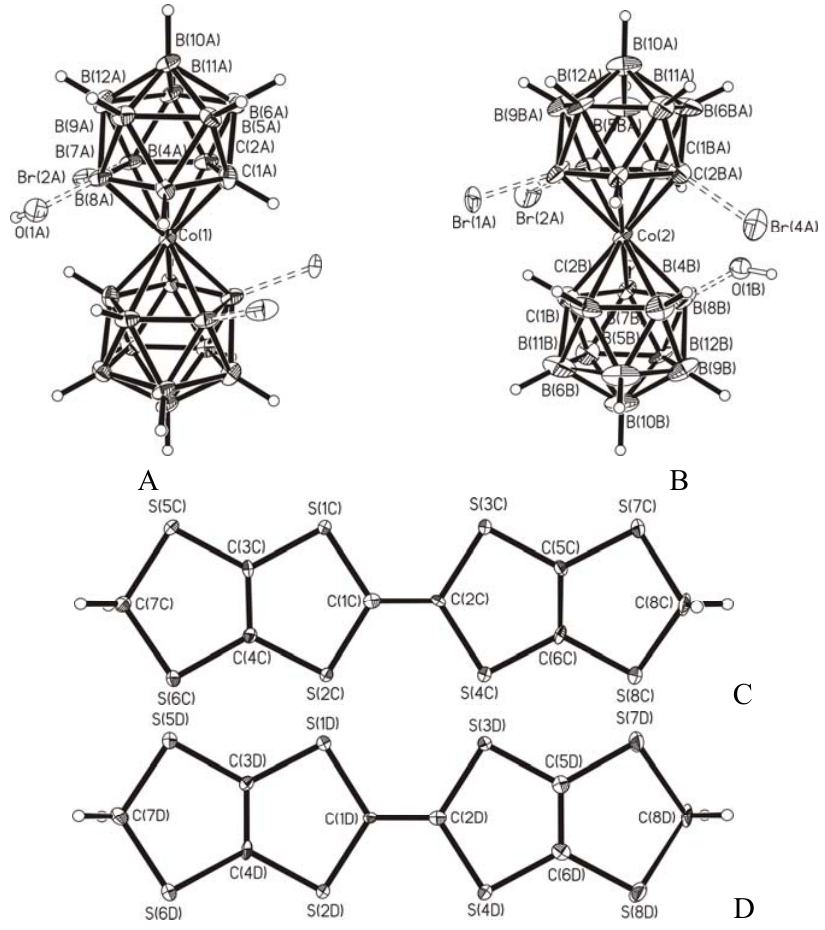
Figure 9. Atom designations in (BMDT-TTF) ( 3 ). The dashed line denotes bonds with atoms in partially populated positions.